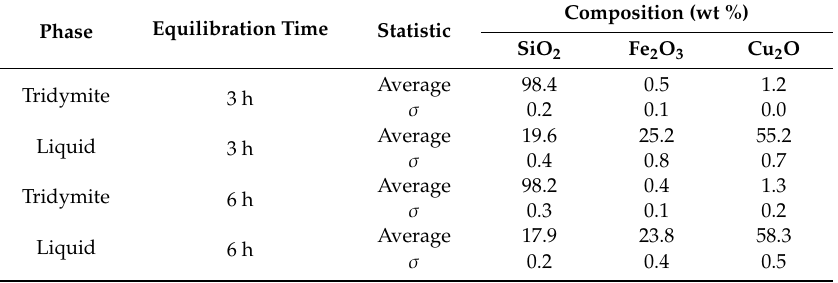
Table 1. Liquid and tridymite average compositions and their standard deviations determined experimentally for the Cu 2 O–Fe 2 O 3 –SiO 2 system in equilibrium with tridymite, saturated with metallic copper, for equilibration times of 3 h and 6 h and temperature of 1200 ◦